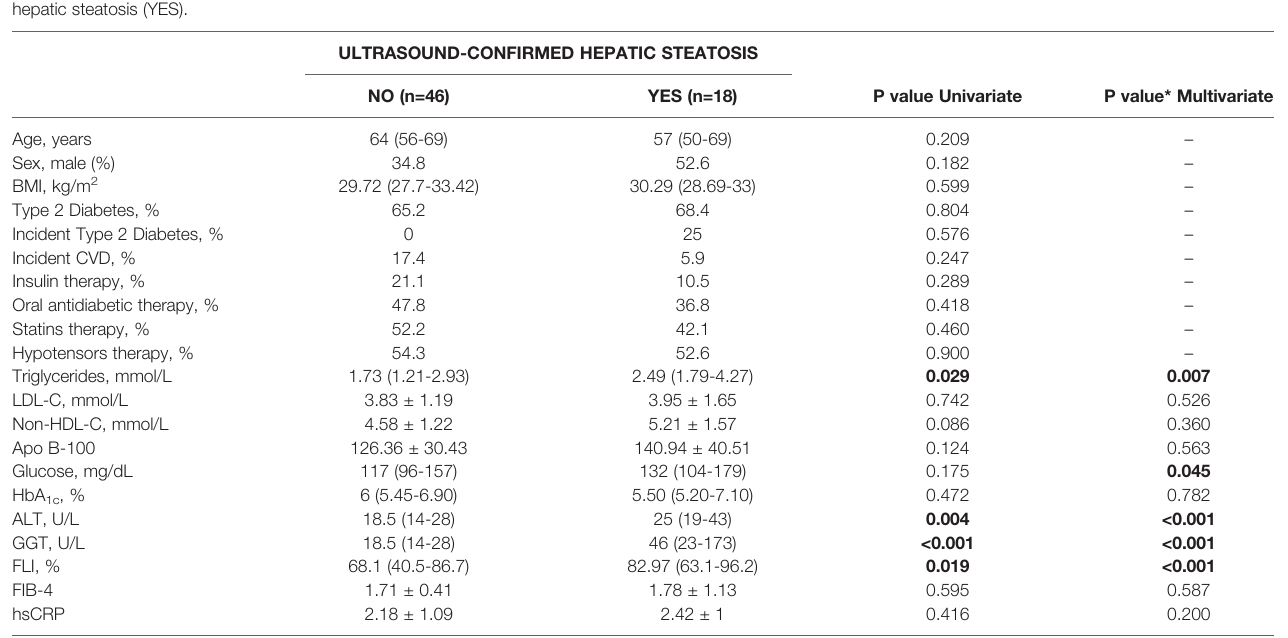
Data are the means ± SD for normally distributed variables, medians (IQR) for nonparametric data or n (%). BMI, body mass index; Incident CVD, incident cardiovascular disease; LDL-C, LDL cholesterol; non-HDL-C, non-HDL cholesterol; Apo B-100, apolipoprotein B100; HbA 1c , glycated hemoglobin; AST, aspartate aminotransferase; ALT, alanine aminotransferase; GGT, gamma-glutamyl transferase; FLI, Fatty Liver Index; FIB-4, Fibrosis-4 score; hsCRP, high-sensitivity C-reactive protein. p values are for group comparisons. Statistical univariate analysis: c 2forcategoricaldata;t-testsorMann-WhitneyUtestswereusedforcontinuousvariables.Statisticallinearmultivariateanalysiscontrolledbyage,sexandBMI.pvalues*arefor group comparisons. Bold values indicate p < 0.05.